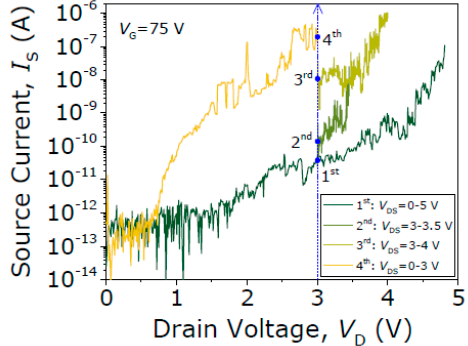
Figure 11. Successive source current versus drain voltage ( I DS -V DS ) sweeps showing the restoring of the contact performance after breaking down the grown native oxide on the W contact site of the relay. V GS is fixed to 75 V to keep the relay in the ON-state.